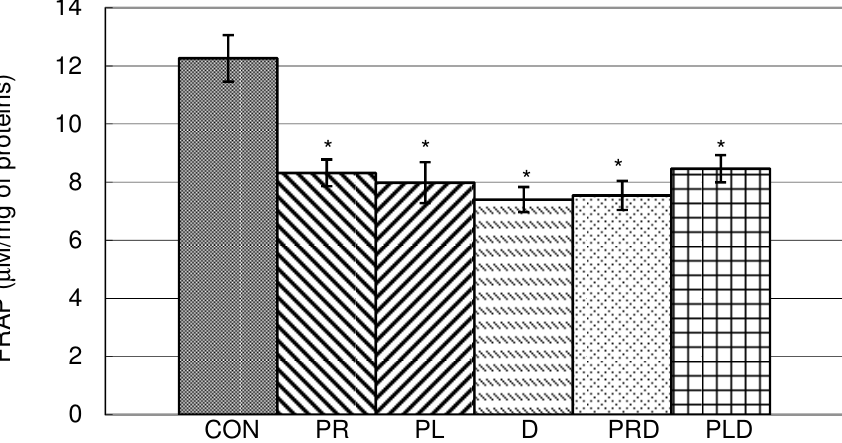
Figure 5. Effects of doxorubicin, parsley leaf and root juices and their combination on FRAP antioxidant capacities in liver homogenate. t-test, n =  6; compared to CON group: * p < 0.05, compared to D group: a p < 0.05.